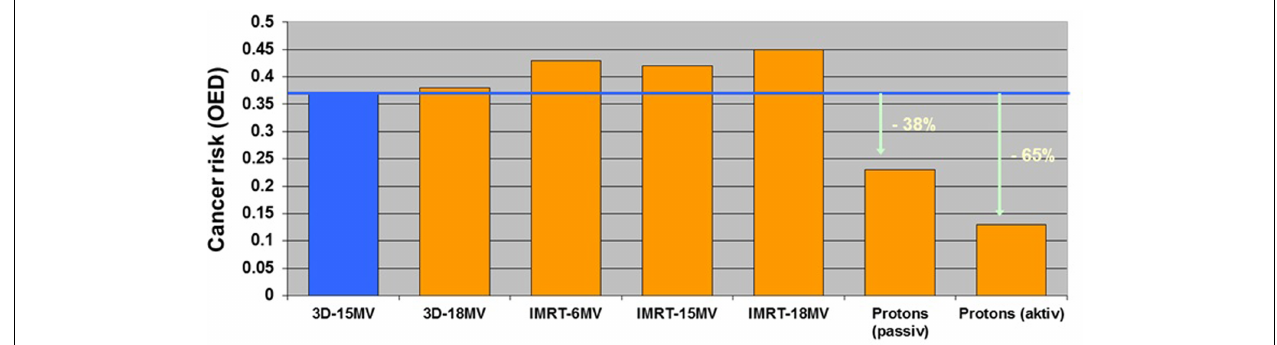
FIGURE 2 | Modeled second cancer risk after radiotherapy of the prostate relative to a historic radiation treatment (four-field-box in blue) . The data were taken from Ref. (14) and updated with better dose measurements (15). Prostate cancer was chosen for comparison with the epidemiological study of Chung et al. (21) as their patient cohort consisted mainly of prostate